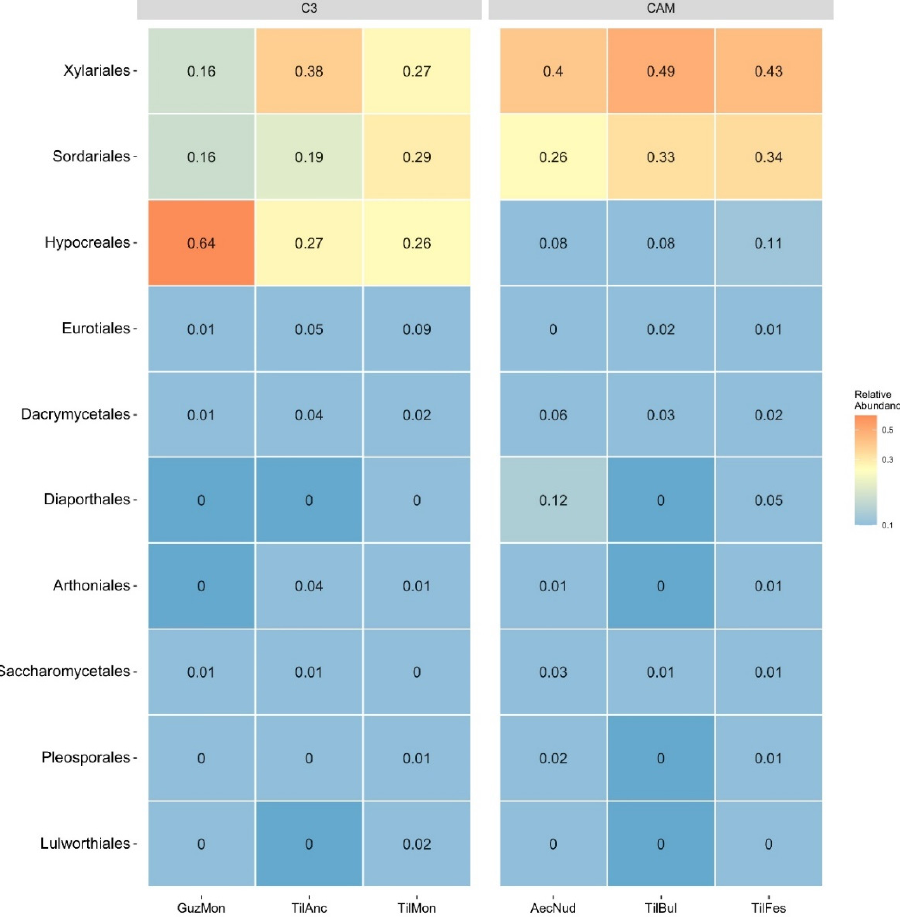
Figure 3. Heat-map of percent relative abundance of fungal orders (left) by host species (bottom); for a list of abbreviations, see (Table 1) and faceted by photosynthetic pathway (top) from the culture-based survey. Numbers within the map are the mean percent relative abundance of fungal orders within a host species.